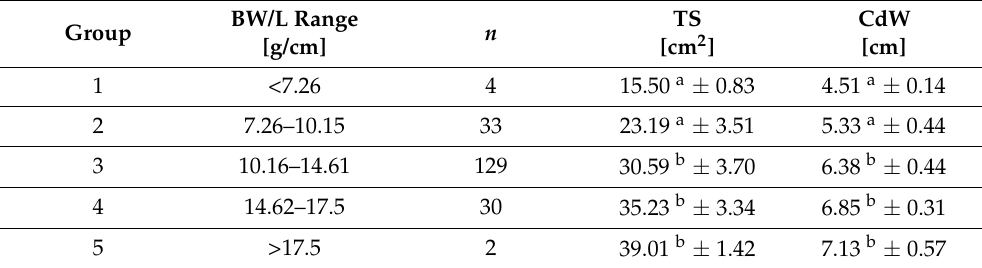
Table 2. Description of the body condition groups of female Xenopus laevis , as grouped by the quo- tient of body weight by length.